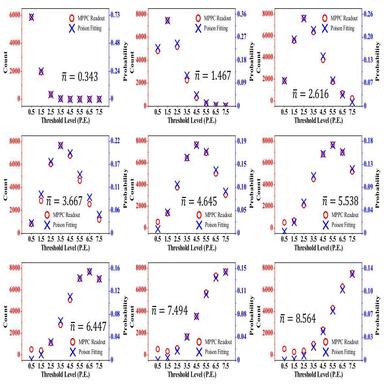
9 sets ofthe photon counts (in red circle) from the MPPC software and their Poison Fitting (in blue cross) against different P.E. level. (For interpretation ofthe references to colour in this figure legend, the reader is referred to the web version of this article).